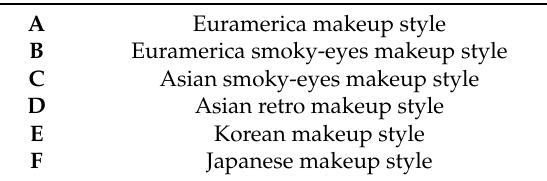
Table 4. Six representative types of makeup style.